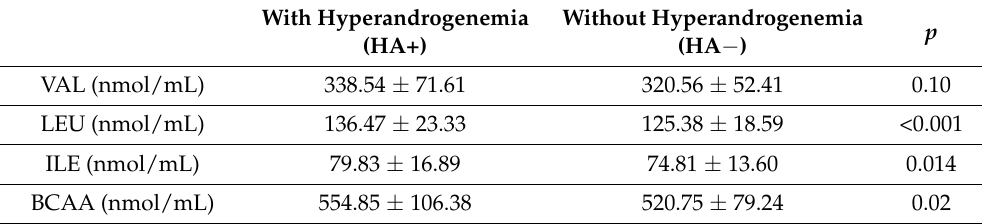
Table 5. Differences in BCAA among PCOS patients with and without hyperandrogenemia. With Hyperandrogenemia Without Hyperandrogenemia p (HA+) (HA − ) VAL